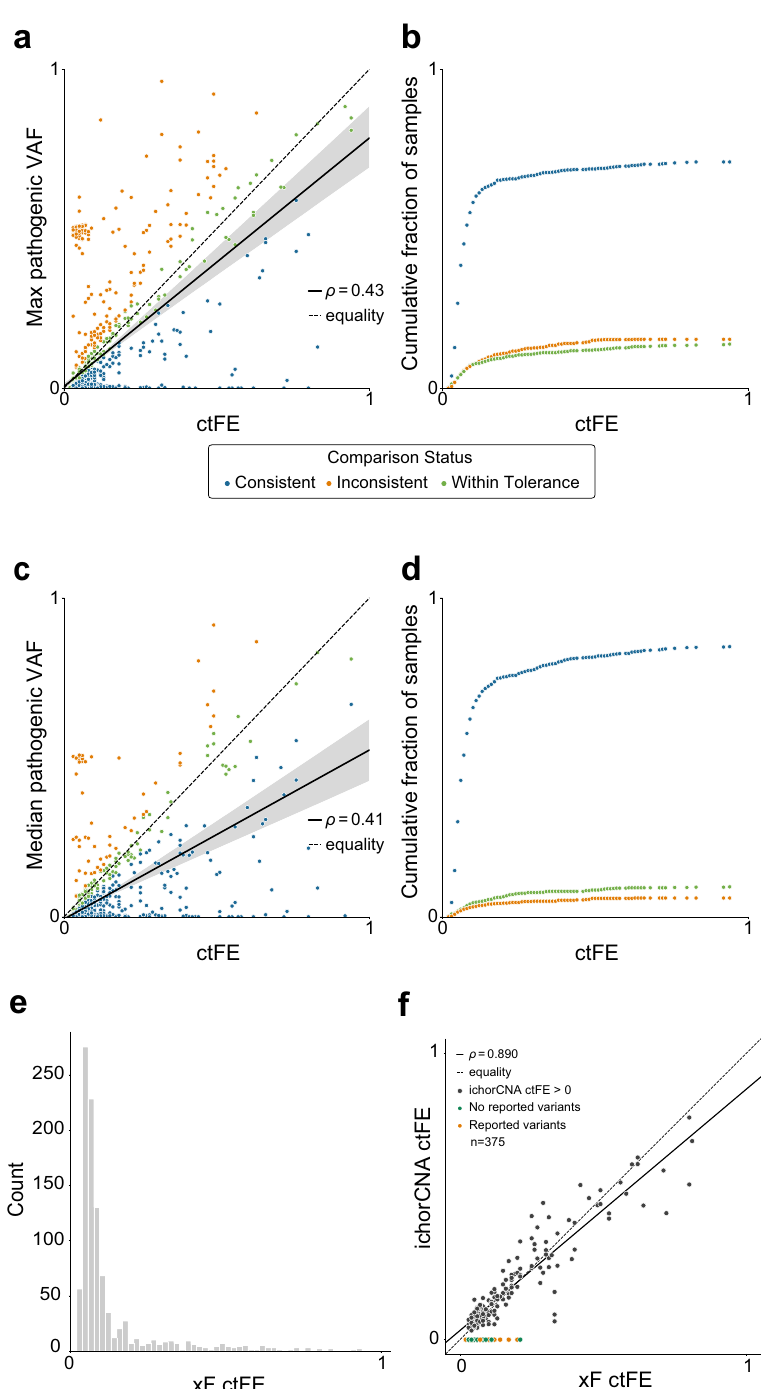
Fig. 2 Circulating tumor fraction estimate (ctFE) and variant allele fraction (VAF). ctFE of xF-sequenced patients ( n = 1000) shows a modest correlation with max pathogenic ( a ) and median ( c ) VAF ( ρ = 0.43 and 0.41, respectively) even after removing likely germline variants and variants that fall within an ampli fi ed region of the genome. A variant can be detected at or below the tumor fraction of the sample, so if the detected VAF was less than the OTTER ctFE it was considered consistent (blue). If the maximum or median VAF was within ±20% of the relative OTTER ctFE, or an absolute 0.02 of the fraction, then the sample was considered within tolerance (green). If the detected VAF was greater than the OTTER ctFE it was considered inconsistent (orange). b , d Cumulative fraction of samples with consistent VAF and OTTER estimates of tumor fraction as the ctFE increases. Overall, 84.7% of samples had OTTER ctFEs within tolerance or consistent with the maximal VAF detected in the sample ( b ). Overall, 94.1% of samples had OTTER ctFEs within tolerance or consistent with the medial VAF detected in the sample ( d ). e The distribution of ctFE across the cohort (median ctFE = 0.07, mean ctFE = 0.12, SD = 0.15). f In samples that also underwent low-pass whole-genome sequencing (LPWGS, n = 375), ichorCNA detected tumor fraction in just 165 samples (black). Among those samples, there was a strong correlation between LPWGS-predicted tumor fraction and OTTER ctFE ( ρ = 0.890). In the majority of samples (60%, orange) with no ctFE detected by IchorCNA, we also detected a variant using the xF assay, indicating that there was detectable tumor DNA and the ichorCNA estimate was a false